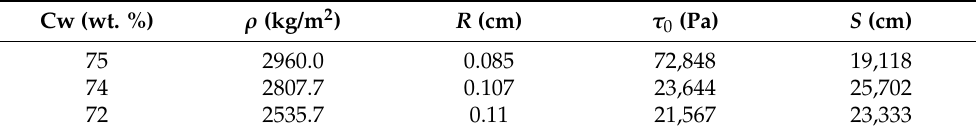
Table 4. Slump height of CWTB at different solids